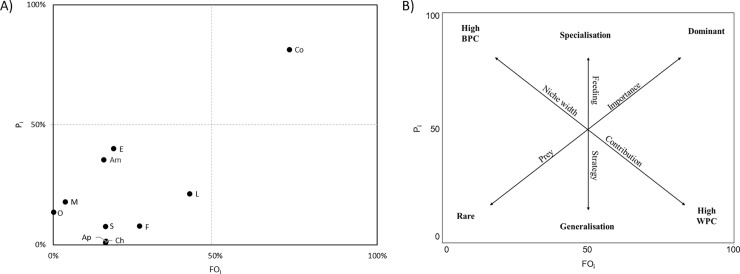
Graphical representation of feeding strategy from the stomach composition of Northeast Atlantic mackerel in Icelandic waters in 2019–2014.A) Feeding strategy shown by plotting frequency of occurrence (FOi%) and prey-specific abundance (Pi%) of prey in diet of fish collected where the prey groups are: M = molluscs; Co = copepods; Am = amphipods; E = euphausiids; L = large crustaceans; S = small crustaceans; F = fish; Ap = appendicularians; Ch = chaetognaths; O = ova. B) Explanatory diagram for interpretation of feeding strategy, prey importance and niche width contribution for mackerel (adapted from Amundsen et al. [42]); BPC, between-phenotype component; WPC, within-phenotype component.